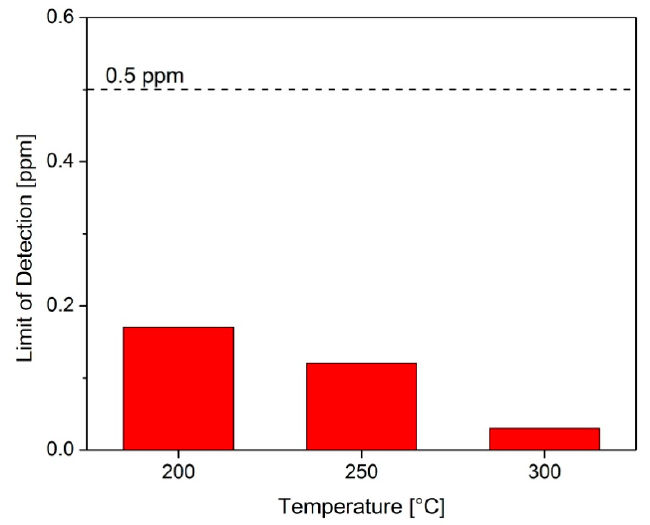
Figure 6. Limit of detection of the single-nanowire (NW) sensor to ammonia at three working temperatures.